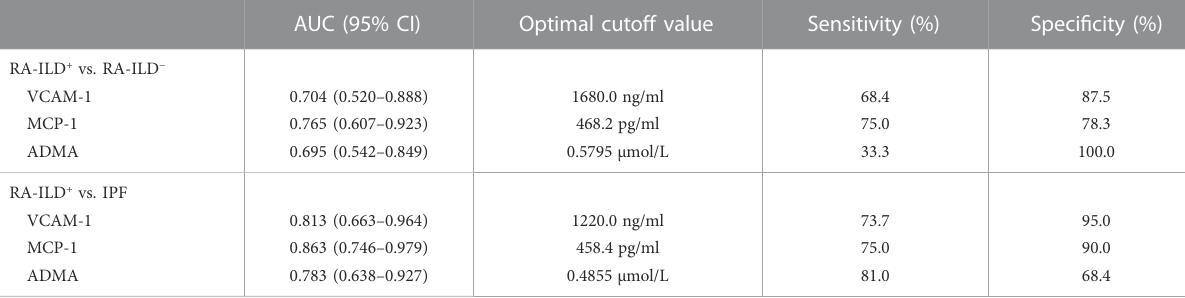
TABLE 2 Receiver operating characteristic curves analysis for the discrimination of RA-ILD + from RA-ILD − and